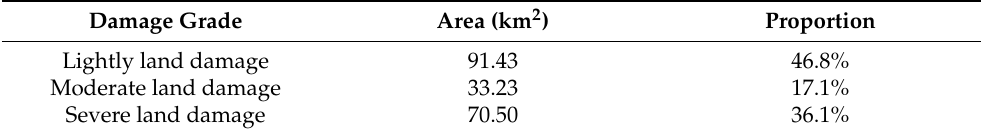
Table 7. Area of damaged land in different